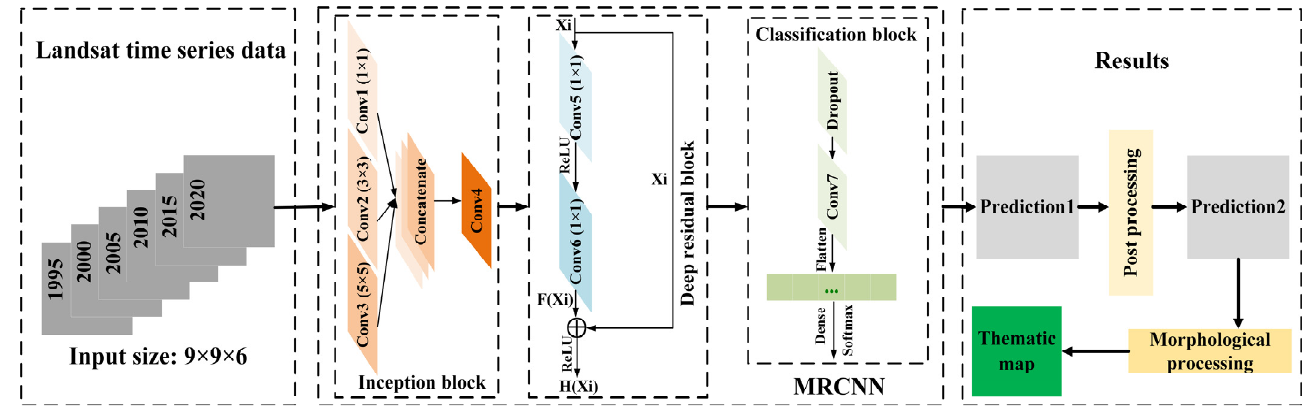
Figure 6. Unified training method based on MRCNN. The left part shows the input multi-temporal dataset, the middle part shows the three main blocks of MRCNN, and the right part shows the post-processing and morphological processing of the classification results to obtain the thematic map of S. alterniflora distribution.